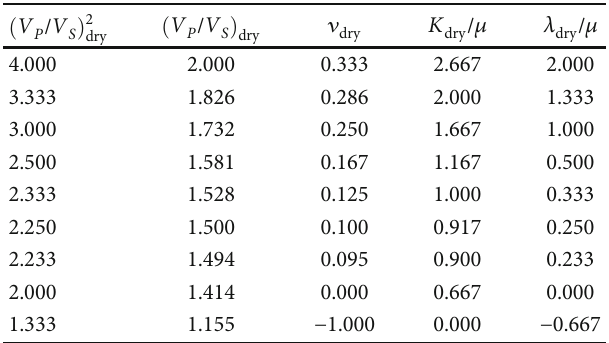
Table 1: The ranges of ð V / μ , and λ K dry